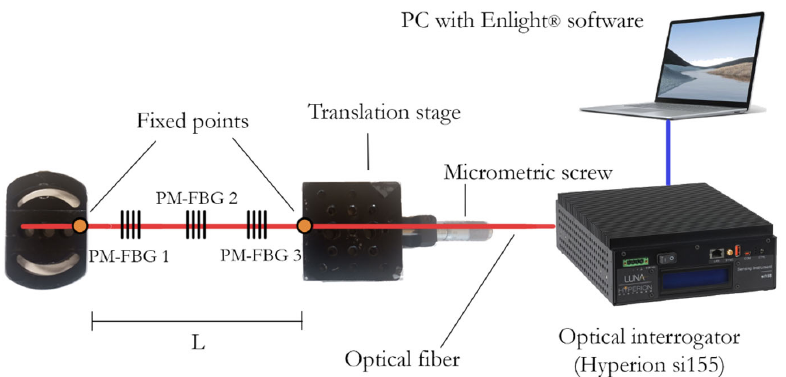
Figure 4. Schematic of micrometric translation stage method. The PM fiber and the PM-FBG sensors were subjected to crescent strain steps, while the optical interrogator performed the Bragg wavelength variation measurement, allowing the correlation of strain variation and the Bragg wavelength shift.